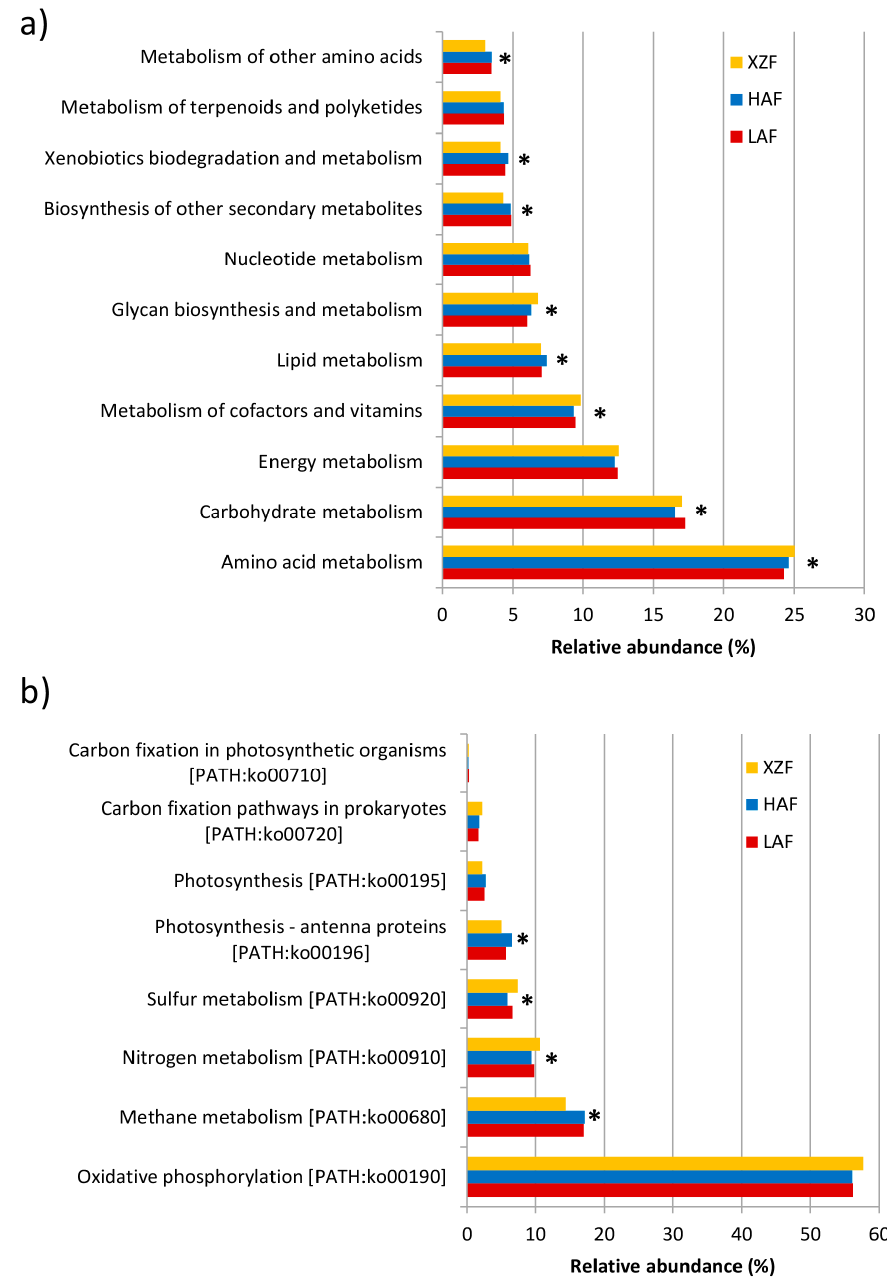
Figure 2. Percentage of contigs for functional groups within level 1—Metabolism ( a ) and Level 2—Energy metabolism ( b ), according to the KEGG Orthology classification of the MG-RAST web-server. Functional groups with statistically significant differences between samples are marked with asterisks.